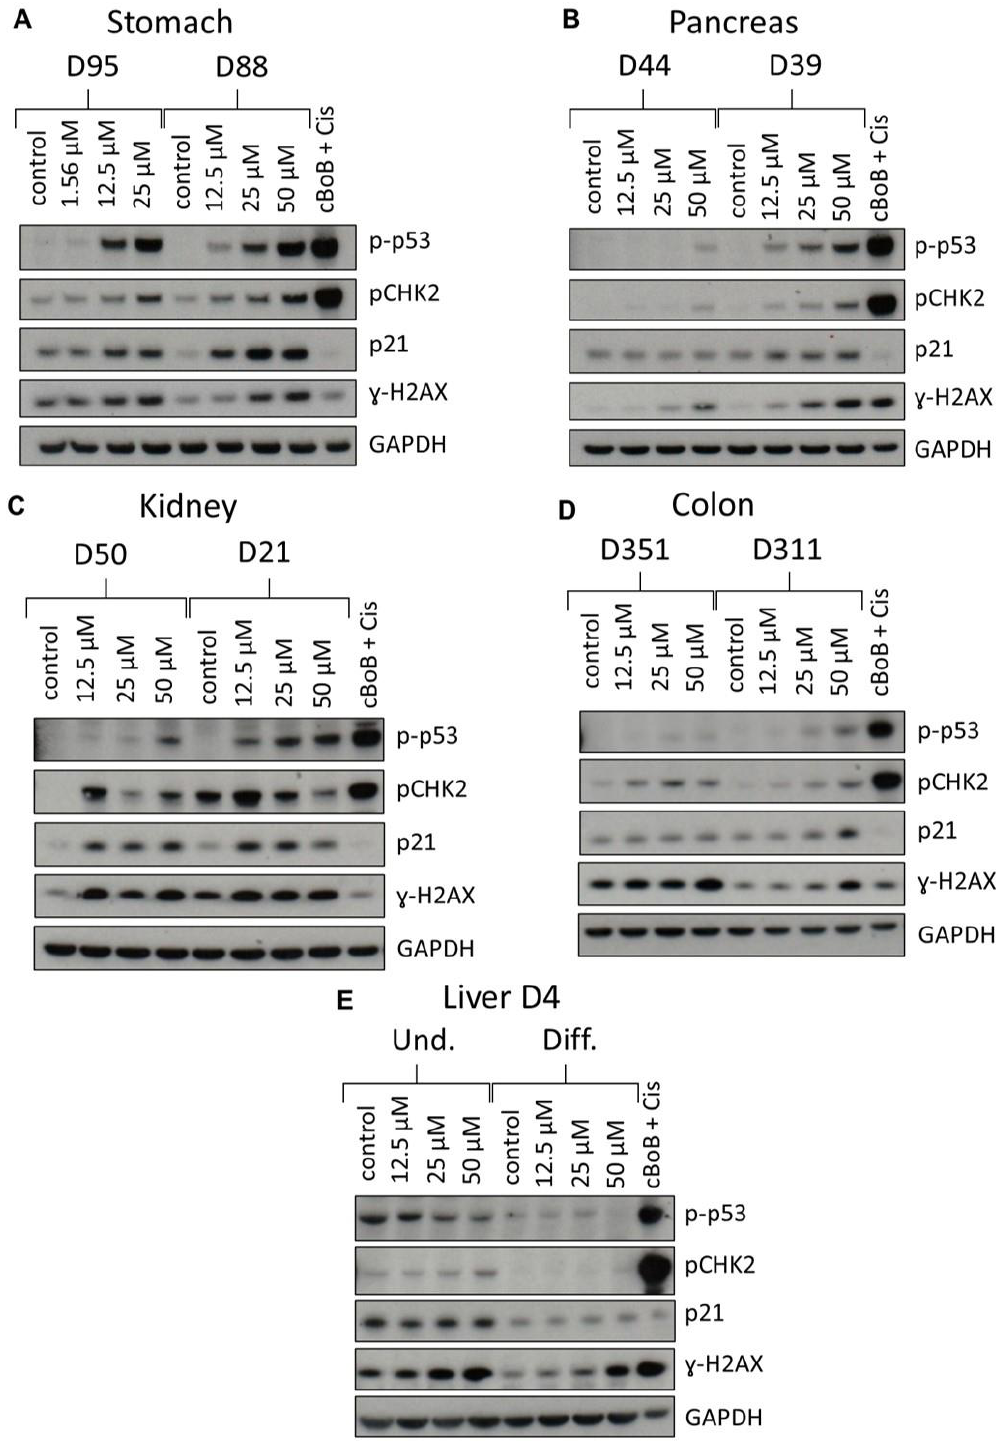
Figure 3. DDR in normal human tissue organoids after BaP treatment. Organoids from gastric D95 and D88; ( A ), pancreatic D39 and D44; ( B ), kidney D50 and D21; ( C ), colon D351 and D311; ( D ) and liver (D4 undifferentiated and differentiated; ( E ) tissues were treated with the indicated BaP concentrations for 48 h, and lysates were analysed by Western blotting. Various DDR proteins (p-p53, pCHK2, p21 and γ -H2AX) were detected and GAPDH was used as a loading control. cBoB + Cis (cBoB treated with 3.125 μM cisplatin) was used as a positive control. Representative blots are shown (n = 2).